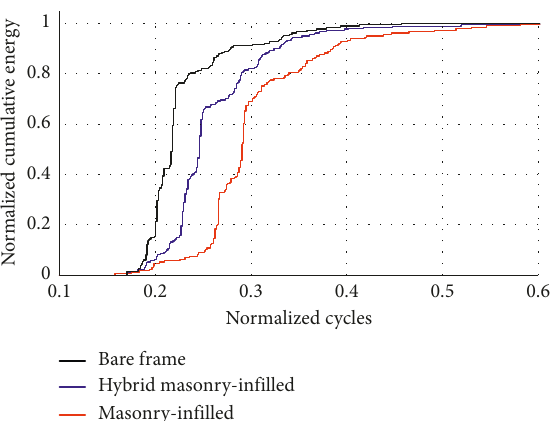
Figure 15: Normalized cumulative energy dissipation of test structures under NR2. A curve with more flatness signifies higher energy